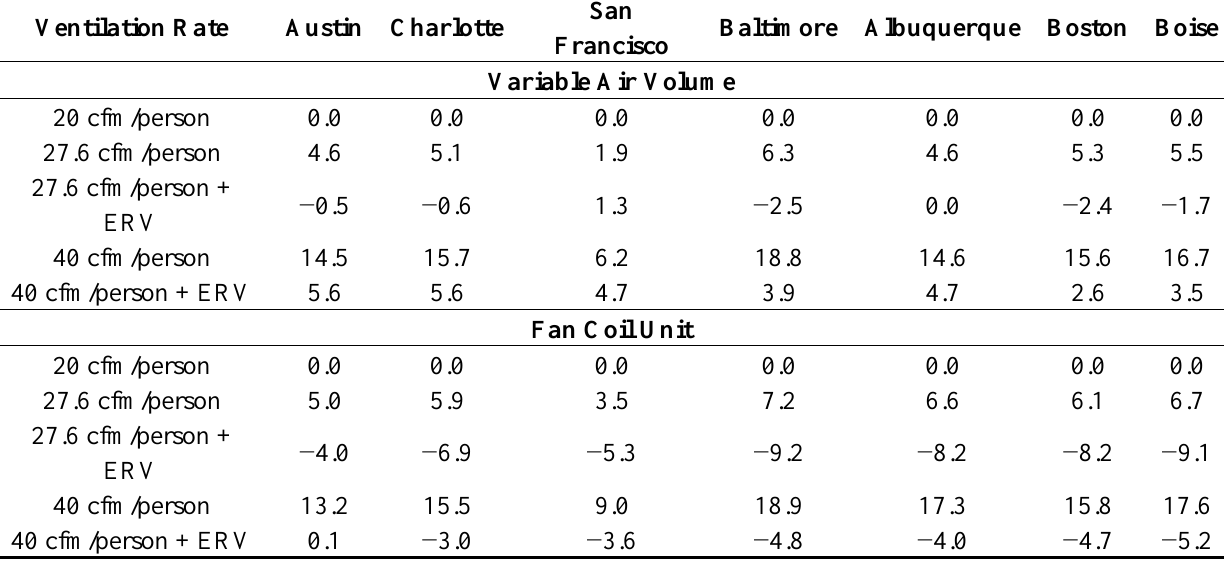
Table 4. Number of additional cars per year on the road per building compared to conventional. Ventilation